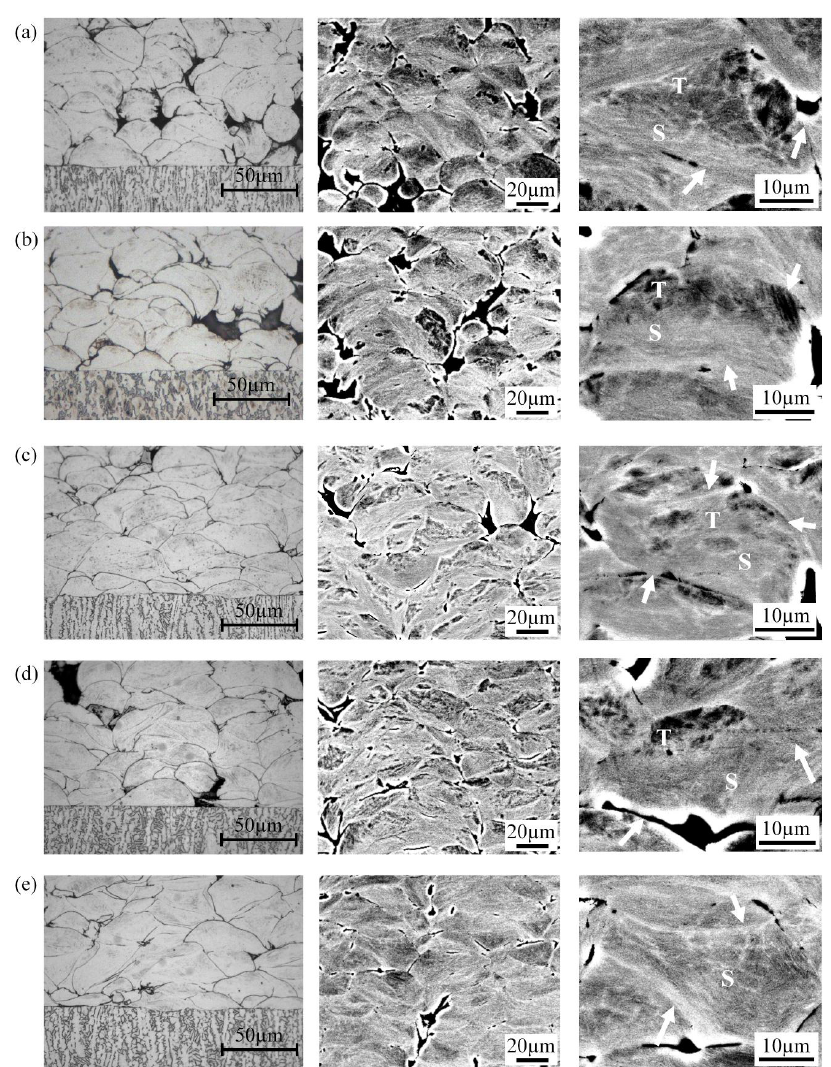
Figure 6. Figure 6. The etched (observed under OM; left column) and unetched cross-sections (observed under back scattered condition; middle and right columns with different magnifications) of the coatings deposited with particle velocities of ( a ) 730; ( b ) 760; ( c ) 800; ( d ) 827 and ( e ) 855 m/s under different magnifications. The textured and smooth regions are labelled with “T” and “S” in the right column, respectively where the arrows indicate the interparticle